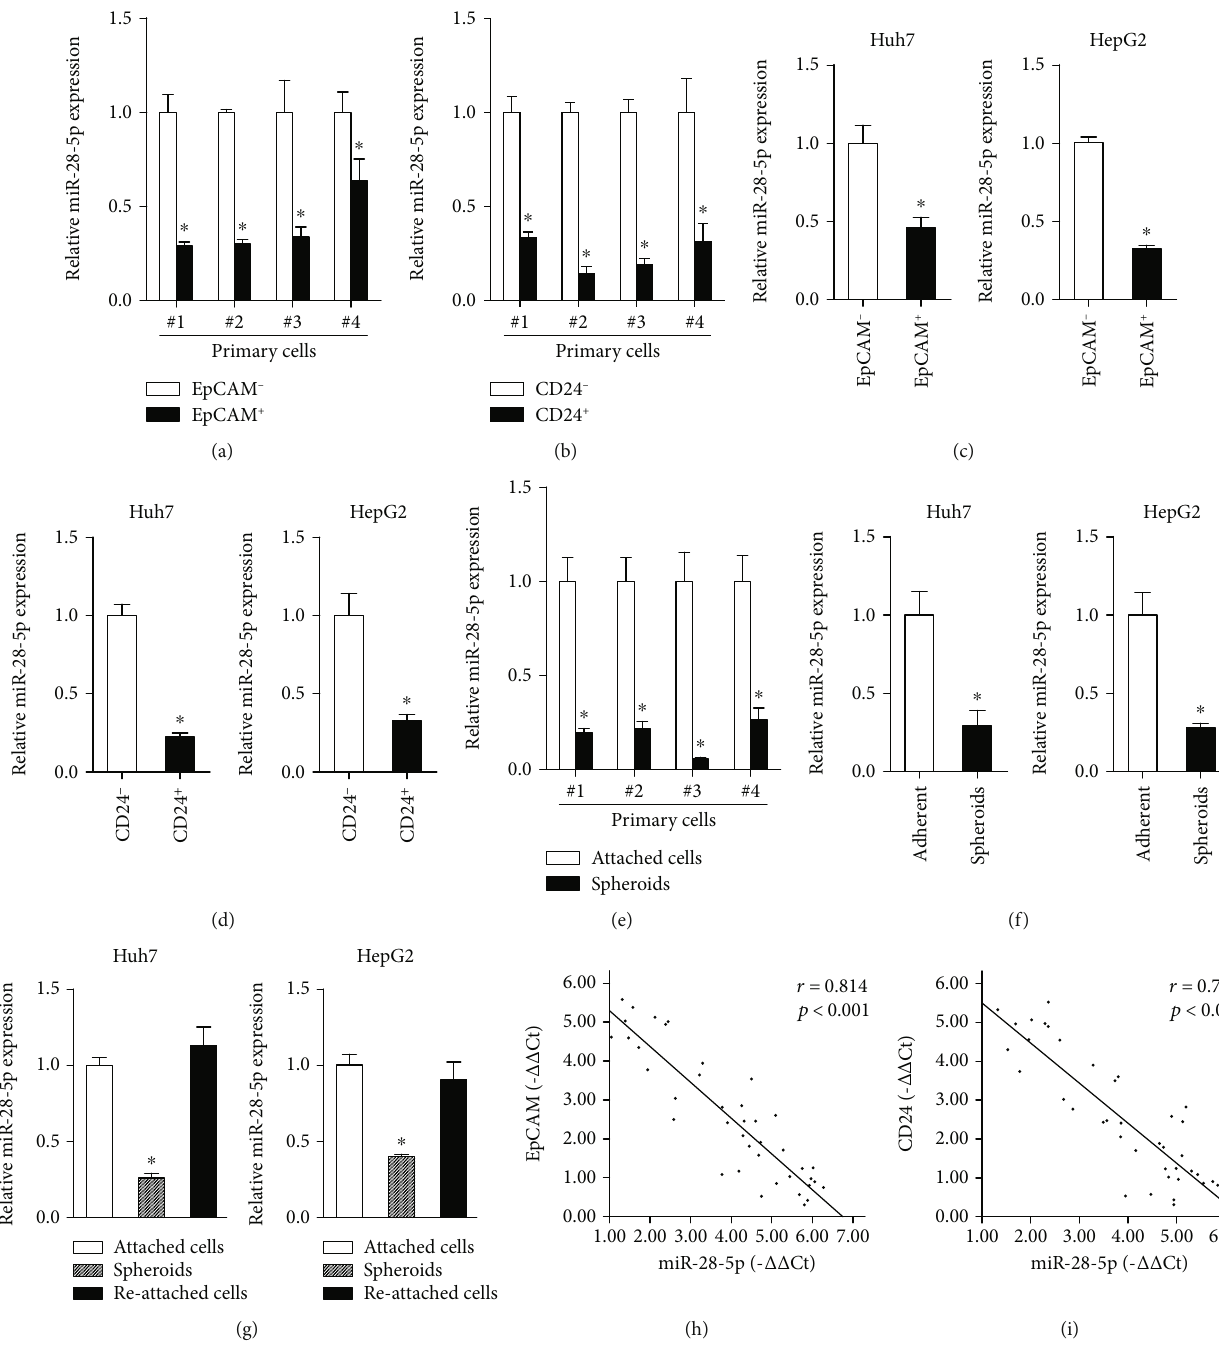
Figure 1: miR-28-5p is downregulated in liver CSCs. (a) EpCAM-positive primary HCC cells and their negative control HCC cells were sorted by fl ow cytometry and then subjected to RT-PCR assay ( n = 3 ). (b) CD24-positive primary HCC cells and their negative control HCC cells were sorted by fl ow cytometry and then subjected to RT-PCR assay ( n = 3 ). (c) Real-time PCR analysis of miR-28-5p in EpCAM-positive HCC cells and EpCAM-negative HCC cells ( n = 3 ). (d) Real-time PCR analysis of miR-28-5p in CD24-positive HCC cells and CD24-negative HCC cells ( n = 3 ). (e) The expression of miR-28-5p in primary HCC spheroid cells and primary HCC adherent cells was determined by RT-PCR assay ( n = 3 ). (f) The expression of miR-28-5p in in HCC spheroid cells and HCC adherent cells was determined by RT-PCR assay ( n = 3 ). (g) The expression of miR-28-5p in attached cells, spheroids, and reattached hepatoma cells was determined by RT-PCR assay ( n = 3 ). (h) The correlation between the transcription level of miR-28-5p and EpCAM in forty HCC tissues was determined by RT-PCR analysis. Data were normalized to U6 or β -actin as Δ Ct and analyzed by Spearman ’ s correlation analysis. (i) The correlation between the transcription level of miR-28-5p and CD24 in forty HCC tissues was determined by RT-PCR analysis. Data were normalized to U6 or β -actin as Δ Ct and analyzed by Spearman ’ s correlation analysis. Data are represented as mean ± s : d : ; ∗ P < 0 : 05 ; two-tailed Student ’ s t